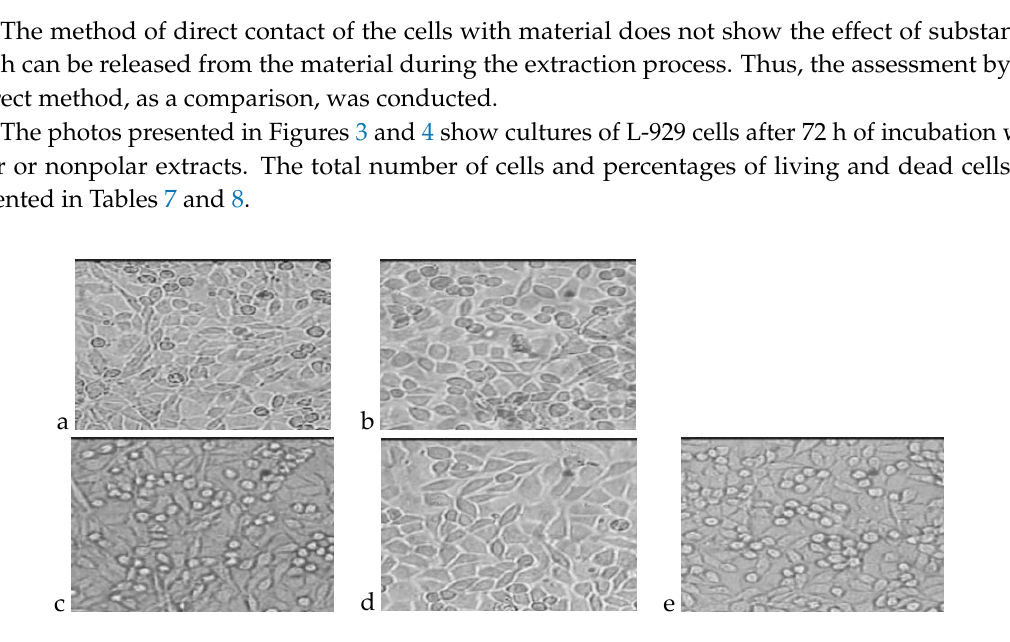
Figure 3. L929 cell cultures obtained during the cytotoxicity test of the indirect method (nonpolar extract) after 72 h of incubation. ( a ) Cells incubated with PLGA extract; ( b ) Cells incubated with PLGA + IGF1 extract; ( c ) Cells incubated with PLGA/PHB extract; ( d ) Cells incubated with PLGA/PHB + IGF1 extract; ( e ) L-929 culture without contact with extract from tested materials.